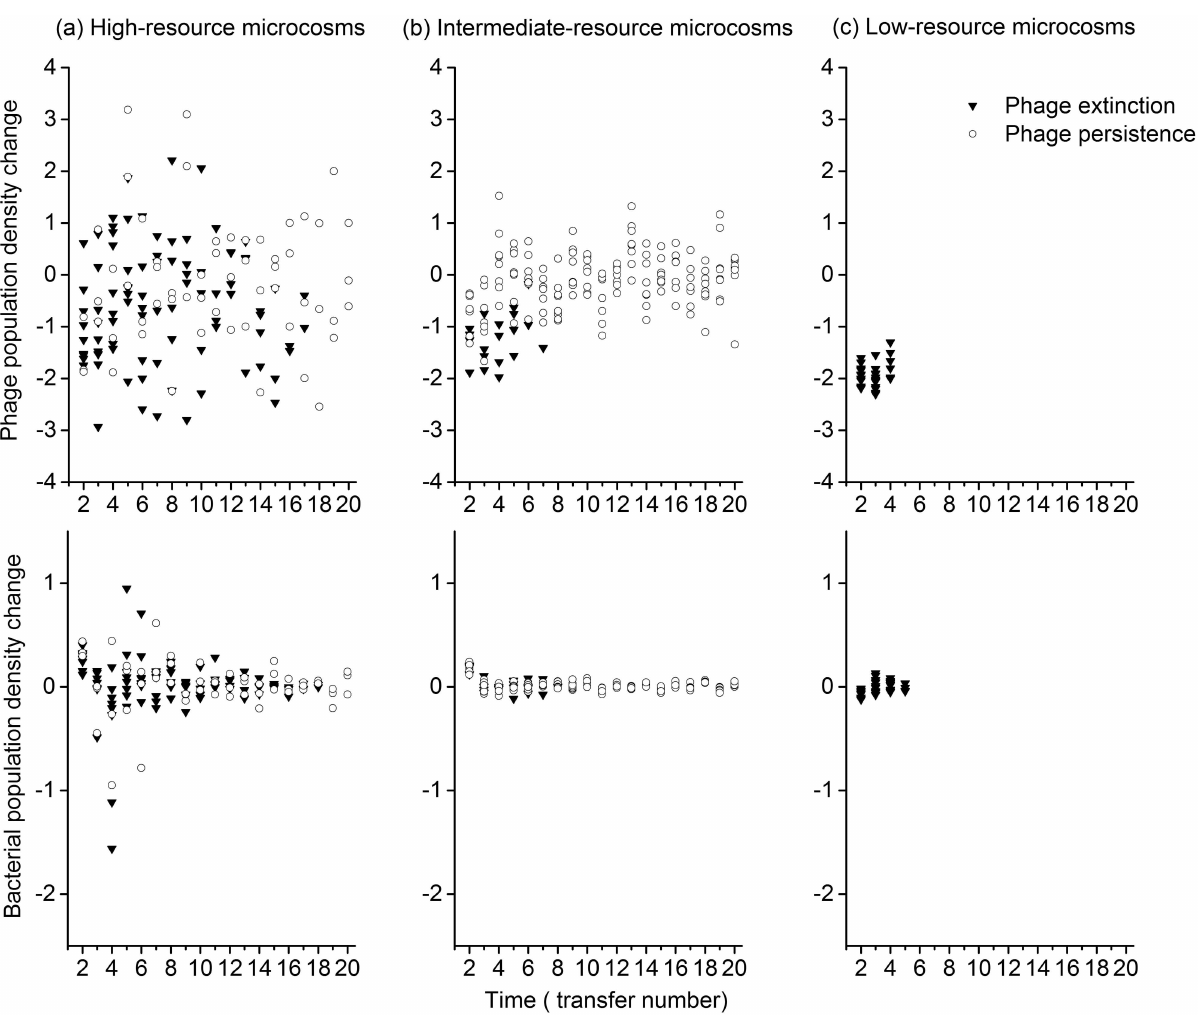
Fig 2. Change in phage and bacterial population densities. Changein phage (top panels) and bacterial (bottom panels) population densities(D t − D t-1 , where D t = log 10 (PFU mL -1 +1) for phage and D t = log 10 (OD 600nm ) for bacteria, representing the populationdensity at transfer t) of each line through time in high- (columna), intermediate-(columnb) and low-resource microcosms (columnc). The positive values indicatethe increasing of populationdensity. The negative values indicate the decreasingof